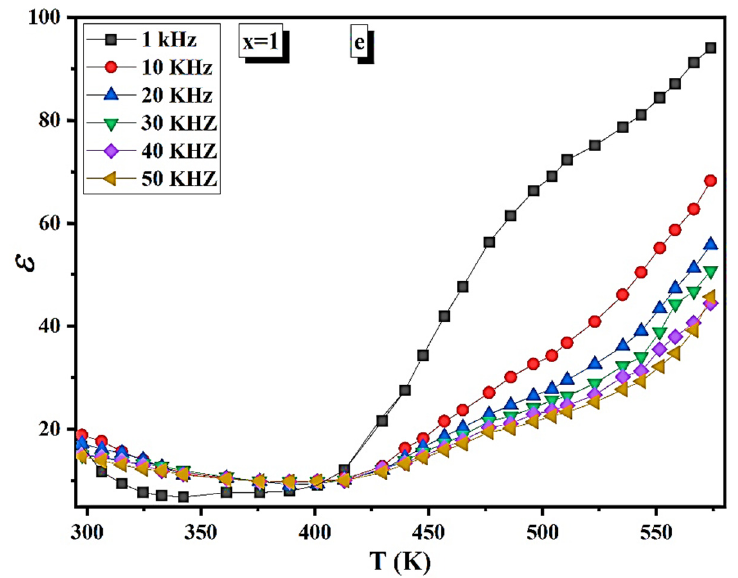
Figure 12. ( a ) ε as a function of the temperature of Ni (cid:2869)(cid:2879)(cid:2934)(cid:2878)(cid:2870) Mg (cid:2934)(cid:2878)(cid:2870) Fe (cid:2870)(cid:2878)(cid:2871) O (cid:2872) (x = 0). ( b ) ε as a function of the temperature of Ni (cid:2869)(cid:2879)(cid:2934)(cid:2878)(cid:2870) Mg (cid:2934)(cid:2878)(cid:2870) Fe (cid:2870)(cid:2878)(cid:2871) O (cid:2872) (x = 0.2). ( c ) ε as a function of the temperature of Ni (cid:2869)(cid:2879)(cid:2934)(cid:2878)(cid:2870) Mg (cid:2934)(cid:2878)(cid:2870) Fe (cid:2870)(cid:2878)(cid:2871) O (cid:2872) (x = 0.6). ( d ) ε as a function of the temperature of Ni (cid:2869)(cid:2879)(cid:2934)(cid:2878)(cid:2870) Mg (cid:2934)(cid:2878)(cid:2870) Fe (cid:2870)(cid:2878)(cid:2871) O (cid:2872) (x = 0.8). ( e ) ε as a function of the temperature of Ni (cid:2869)(cid:2879)(cid:2934)(cid:2878)(cid:2870) Mg (cid:2934)(cid:2878)(cid:2870) Fe (cid:2870)(cid:2878)(cid:2871) O (cid:2872) (x = 1).